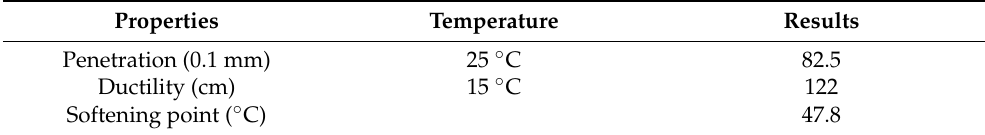
Table 2. Basic Properties of the virgin bitumen.